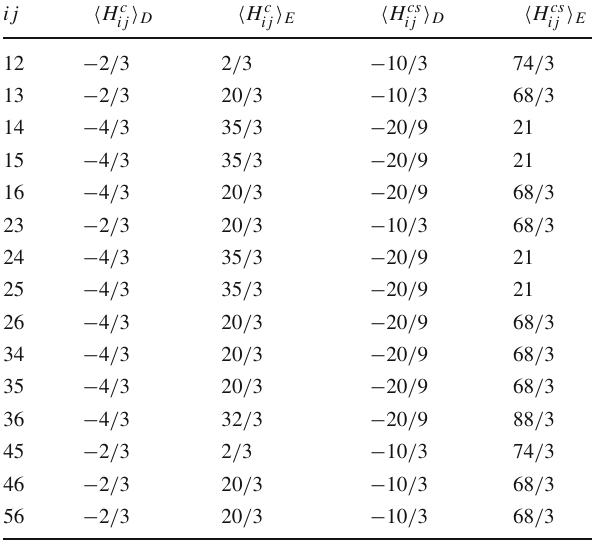
Table 8 The matrix elements in spin-flavor-color-isospin spaces of the hidden-color channel for the Ω ccc Ω ccc system with J P = 0 +